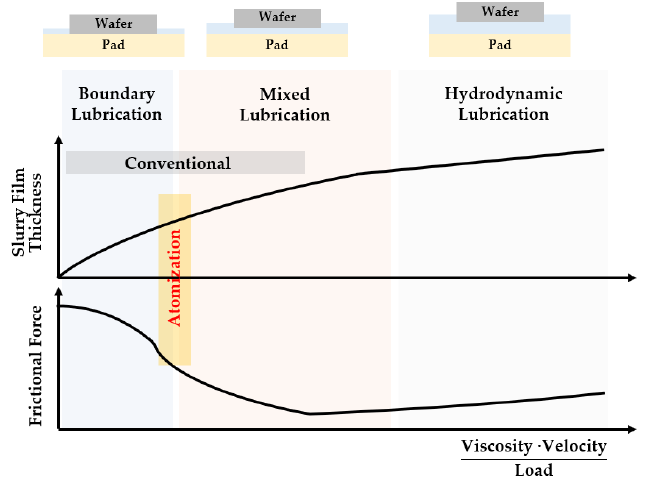
Figure 14. The frictional force and slurry film thickness. Both the factors are expressed as a function of fluid viscosity and velocity divided by the load.